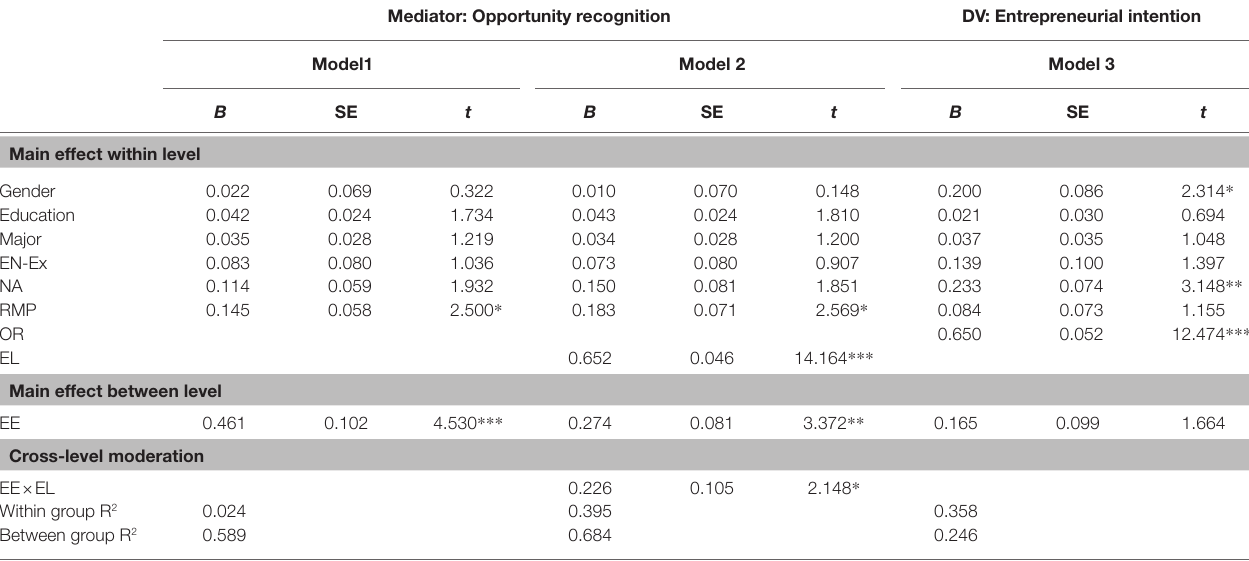
TABLE 4 | Results of multilevel regression analysis with entrepreneurship education as independent